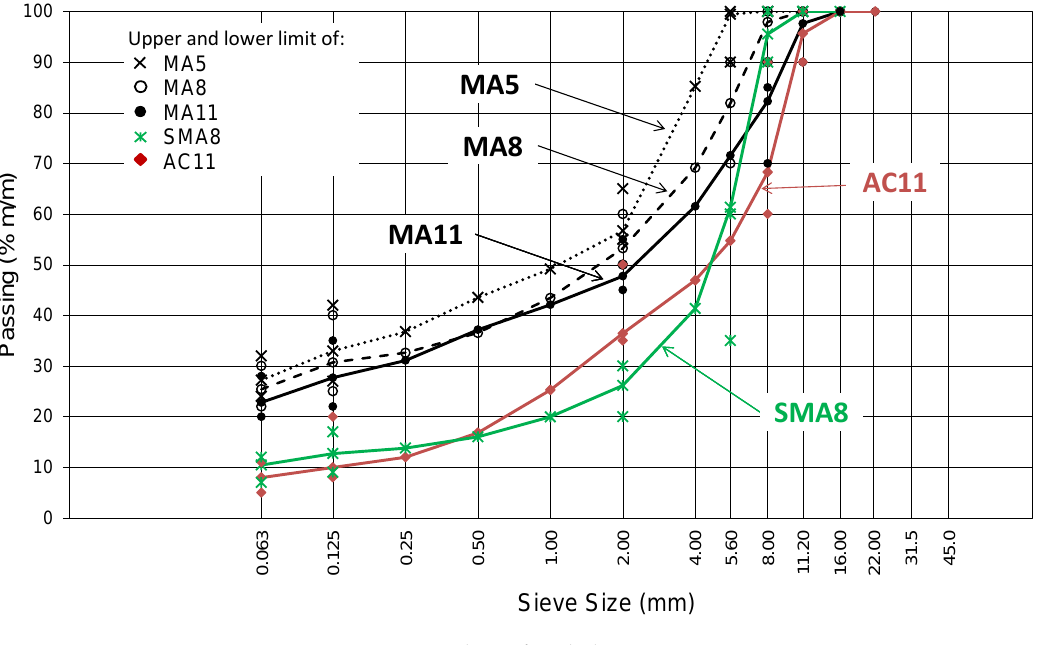
Figure 1. Grading of asphalt mixtures. Table 1. Composition and volumetric properties of asphalt mixtures.